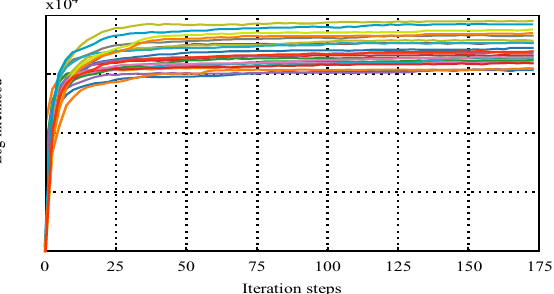
Figure 10. The log–likelihood of modeling the training data for all drivers.